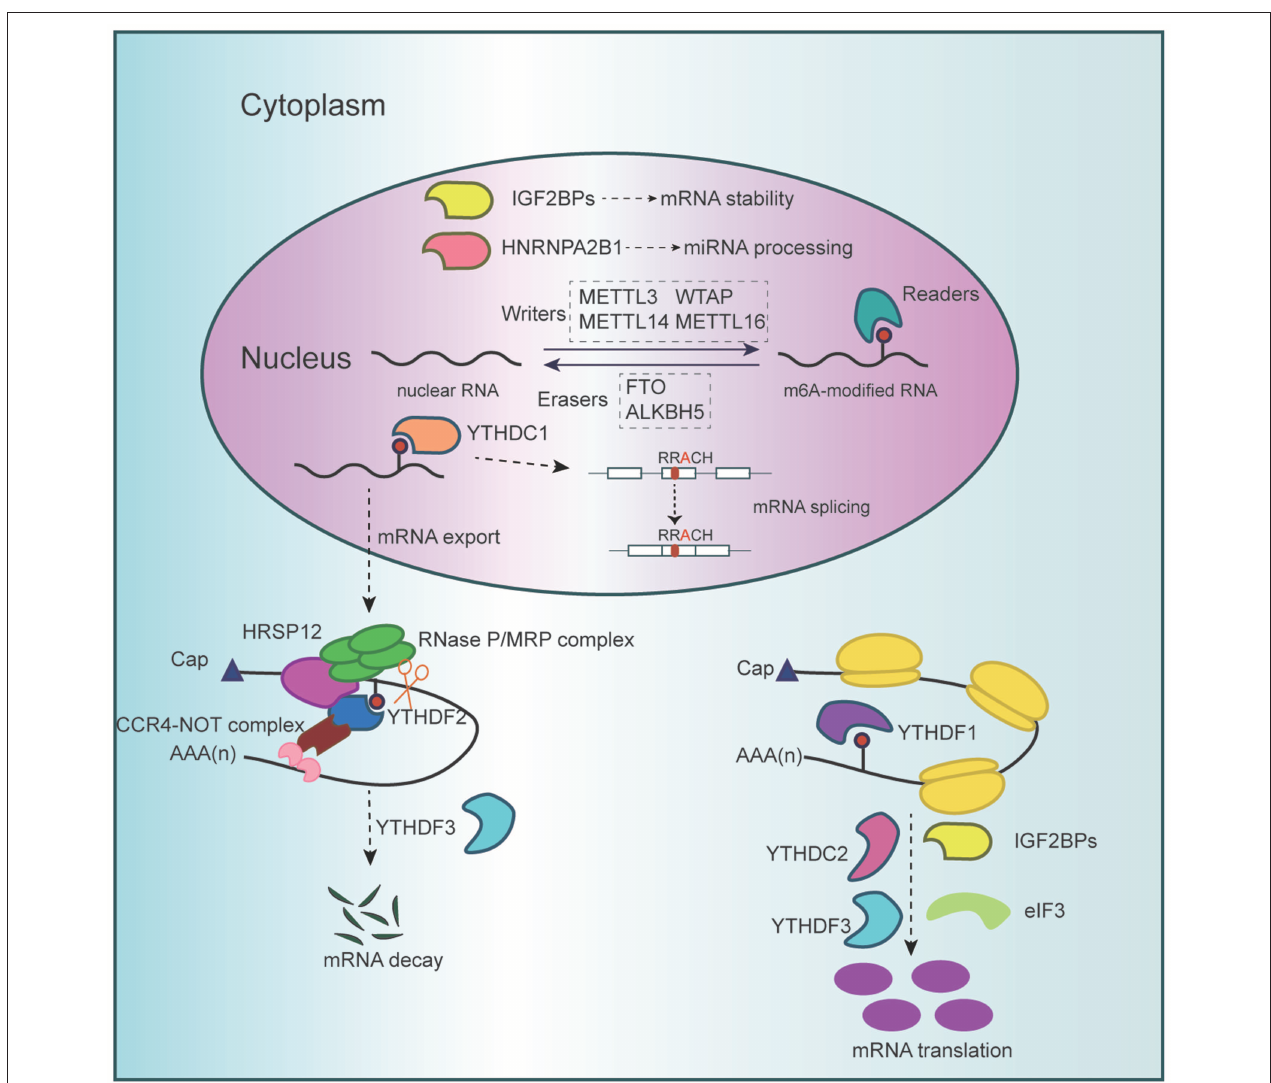
FIGURE 1 | Schematic diagram of RNA m 6 A methylation. The methyltransferase complex (METTL3, METTL14, WTAP, and METTL16), which catalyzes methylation at the N6 position adenosine, and the demethylases (FTO and ALKBH5), which remove methyl groups, dynamically regulate cellular m 6 A levels in the nucleus. Besides, m 6 A modification could be specifically recognized and bound by diverse reader proteins. Nuclear m 6 A readers promote miRNA processing while affecting mRNA splicing, stability, and export. Cytoplasmic readers mediate m 6 A-marked mRNA translation and